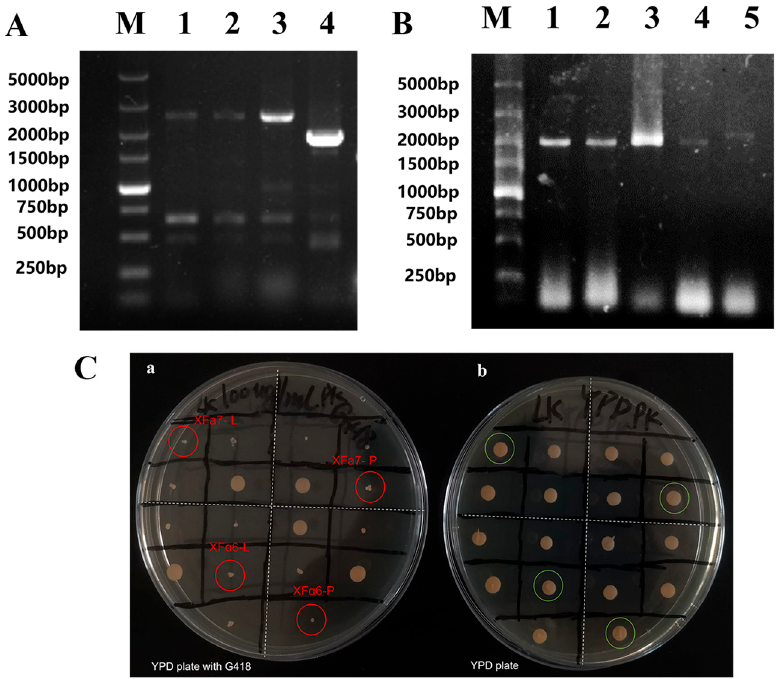
Figure 1. Construction results of haploid recombinant yeast strains. ( A ) PCR verification of recom- binant yeasts with LEU1 deletion. M, DL 5000 DNA Marker; lanes 1 − 3, recombinant strain bands: 2505 bp; lanes 4, wild-type strain band: 1891 bp. ( B ) PCR verification of recombinant yeasts with PDC5 deletion. Lanes 1 − 4, recombinant strain bands 2092 bp. lanes 5, wild-type strain band: 2345 bp. ( C ) Veri fi cation of the removal of resistance markers in haploid recombinant strains.